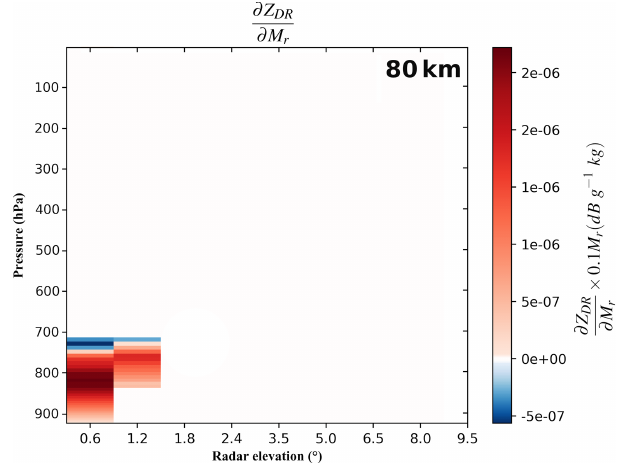
Figure 11. Z DR Jacobian for a rain content perturbation associated with the AROME hydrometeor profile shown in Fig. 10 located at 80km from the radar. The Jacobians are normalized by 10% of the hydrometeor